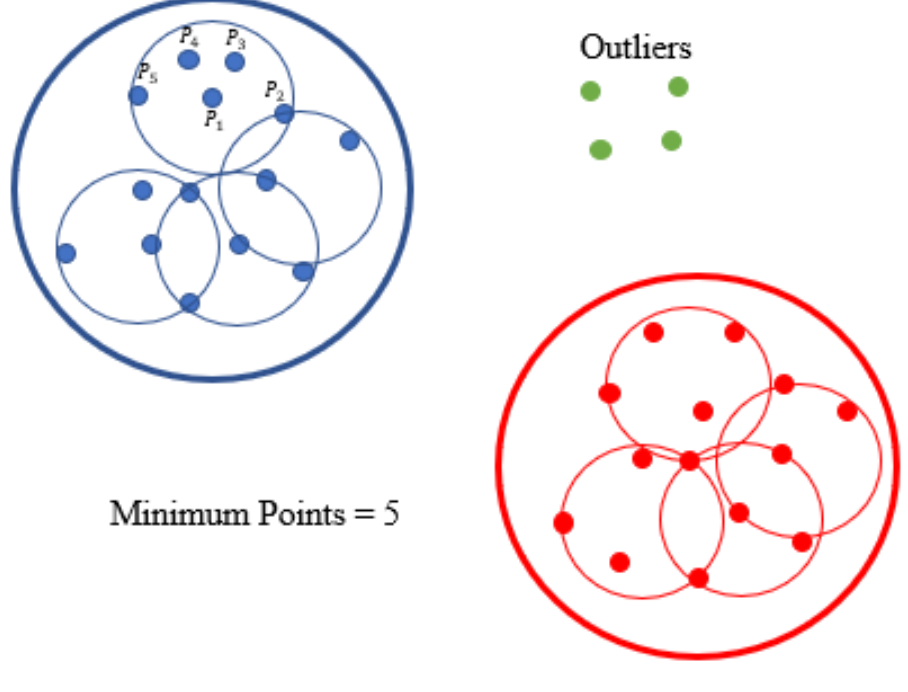
Figure 6. Visual representation of DBSCAN.